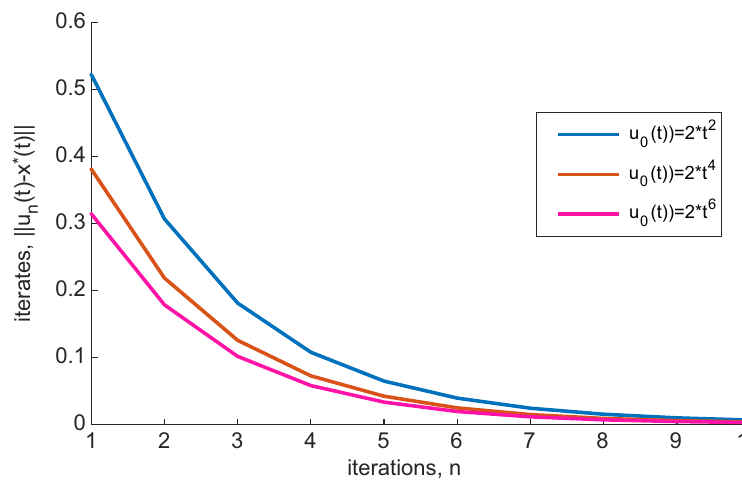
Figure 1: Convergence of the sequence u n { } generated by ( 54 ) with di ff erent initial